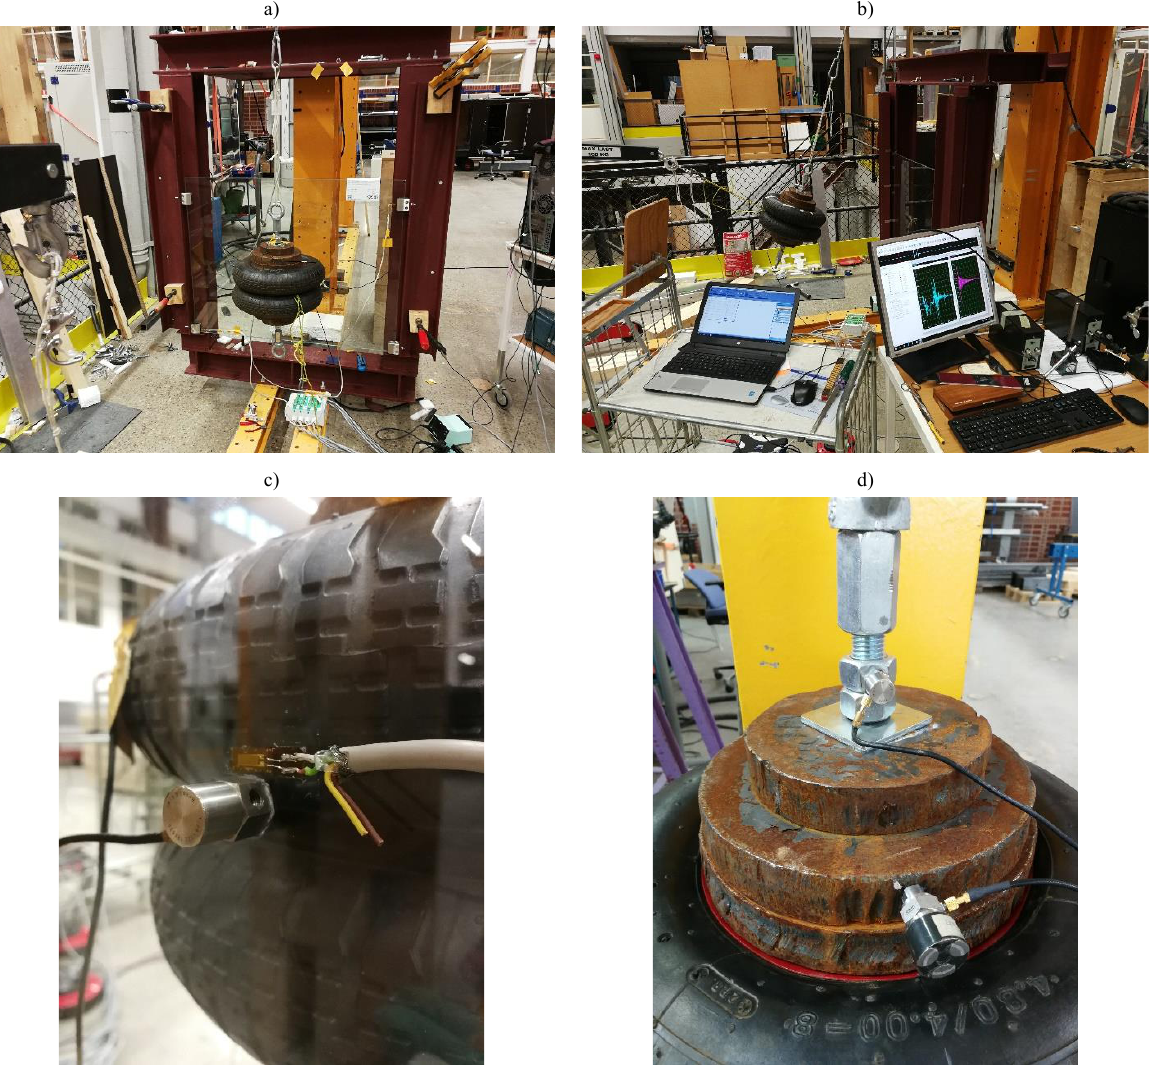
Fig. 2 Soft-body impact test set-up: a) steel rig, b) computers logging data from strain gauges and accelerometers, c) strain gauge and accelerometer mounted to the glass specimen, d) accelerometer mounted to the impactor. Specimens I-V were tested in a custom-made steel frame of high stiffness (Fig. 2a). The set-up allowed for fixing the various specimens and releasing the impactor from defined drop heights. To measure the structural response of the glass elements during soft-body impact, two systems with a number of sensors were installed (Fig. 2b). To measure strains in glass, strain gauges with a measurement length of 10 mm and a single axis accelerometer were bonded to the specimens (Fig. 2c). The signals from the strain gauges were logged at a frequency of 600 Hz, whereas the readings from the accelerometers were recorded at 5 kHz. A single-axis accelerometer was also mounted to the impactor (Fig. 2d). To obtain statistically reliable results, at least six repetitions for each drop height were performed. All tests were carried out at a temperature of 22±1